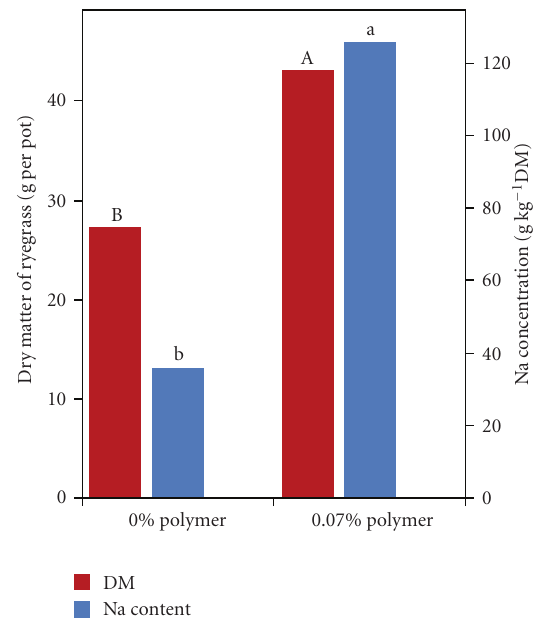
Figure 1: Yield and Na concentration of perennial ryegrass grown in a soil without or with 0.07% sodium polyacrylate polymer. A and B for dry matter, and a and b for Na concentration—statistically di ff erent as evaluated by the Newman-Keuls test at P < .